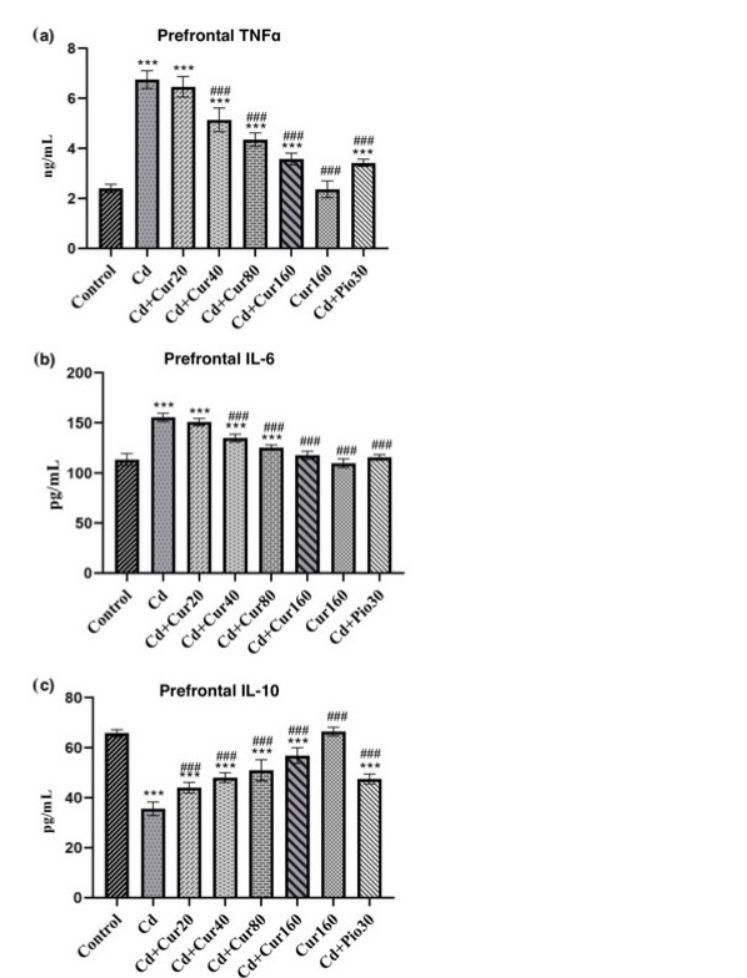
Figure 6. Effect of curcumin on Cd exposed mice showing the status of inflammatory markers; ( a ) IL-6 ( b ) TNF α ( c ) IL-10. Each column represents the mean ± SEM of 7 animals. One-way ANOVA followed by Dunnett’s post-test; *** p < 0.001 showing significant differences between control and treatment group. ### p < 0.001 and showing significant differences between Cd exposed group and curcumin treated groups.